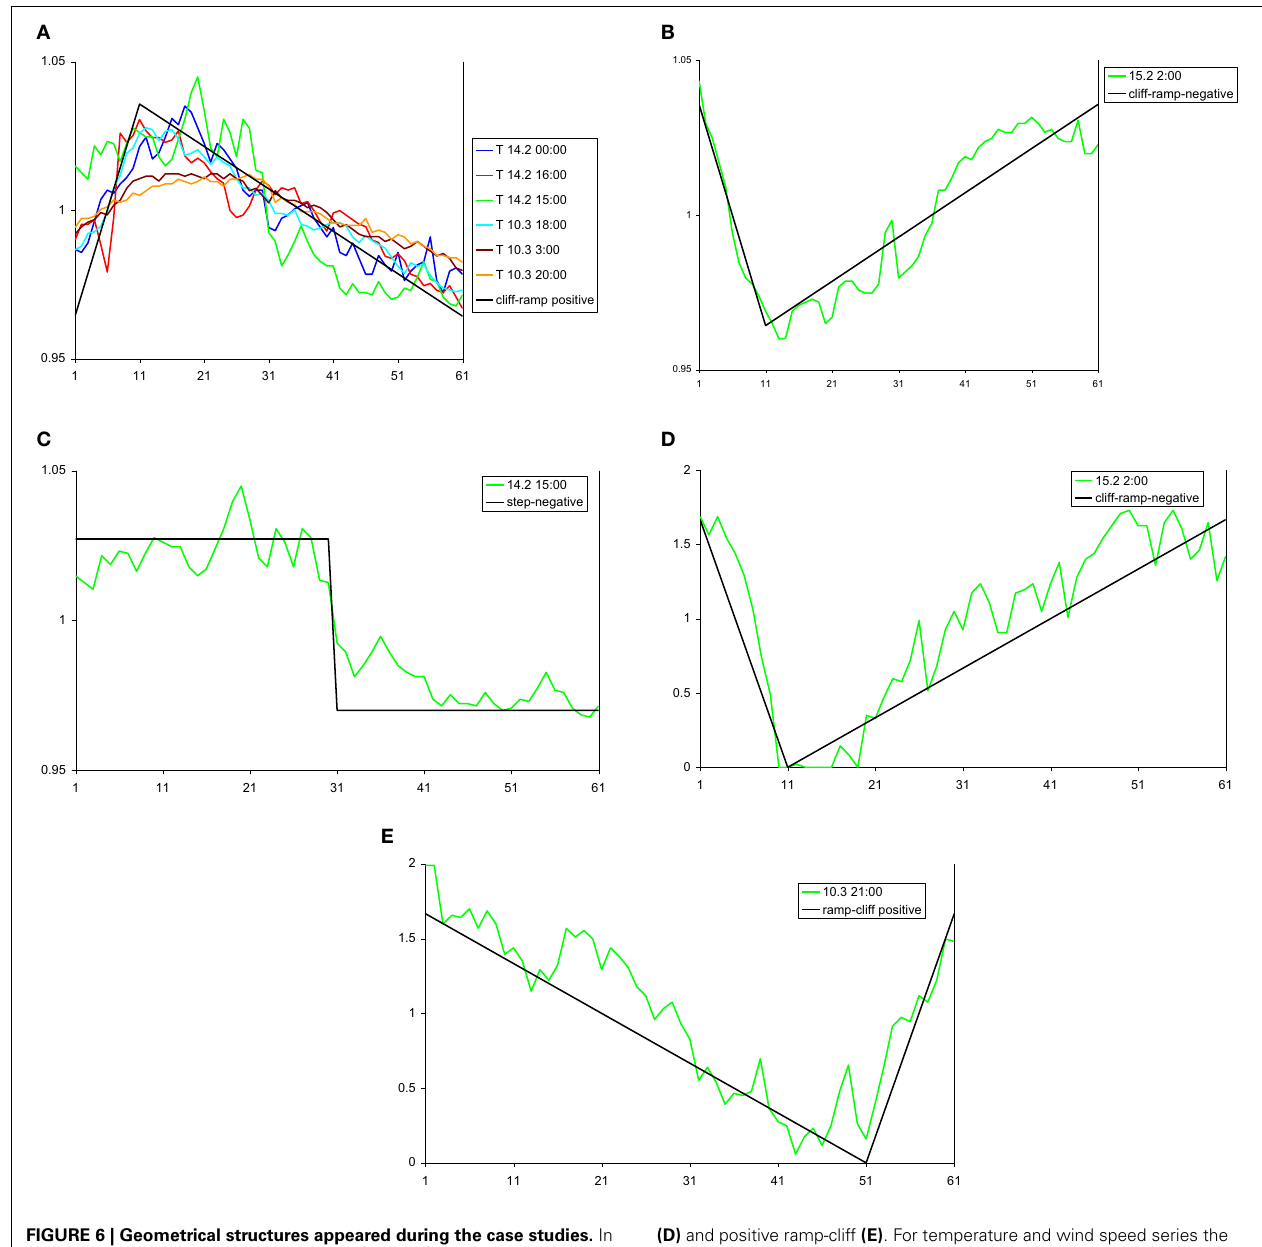
FIGURE 6 | Geometrical structures appeared during the case studies. In the temperature field: cliff-ramps with positive (A) and negative gradient (B) , and negative step shapes (C) . In the wind speed field: negative cliff-ramp